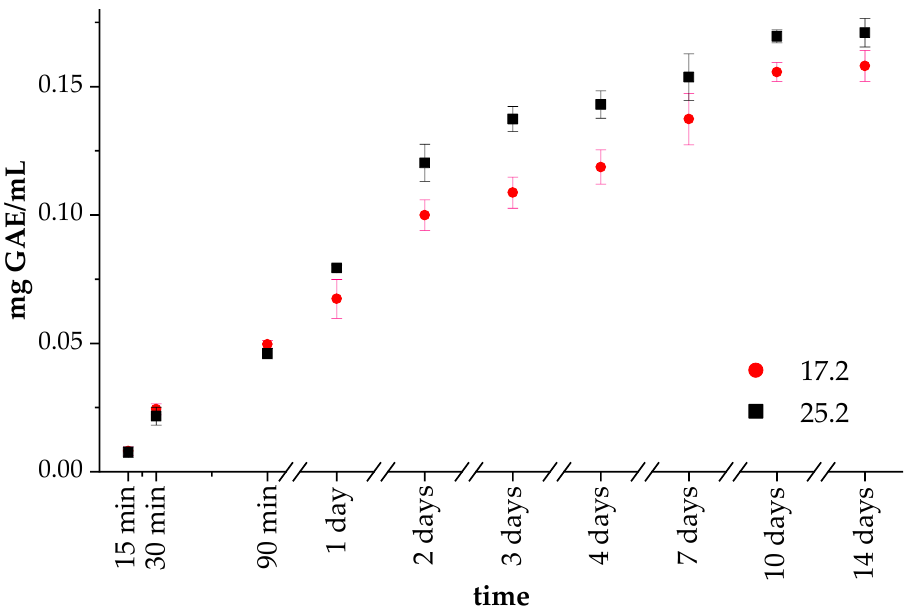
Figure 5. Release profiles of extract from samples 17.2 and 25.2.